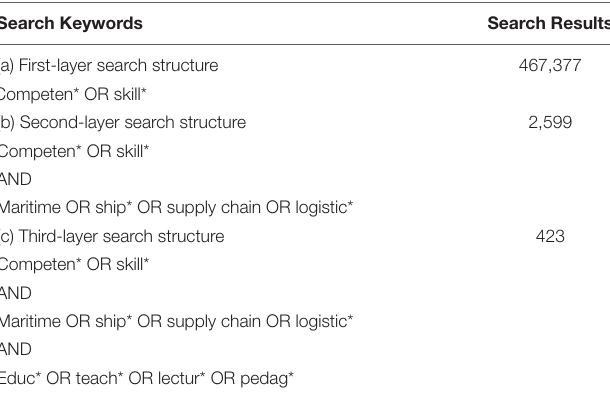
TABLE 3 | Procedure and results of literature